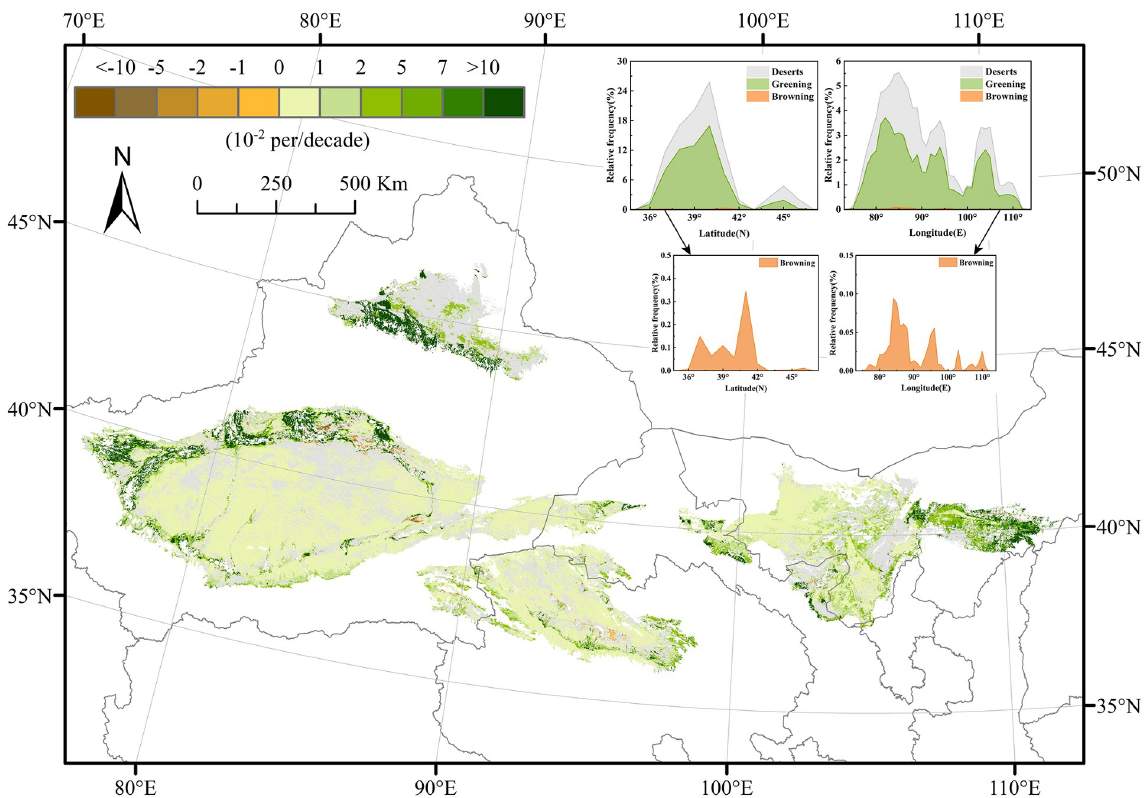
Fig 4. Spatial distribution of greening and browning trends and statistical results based on the longitude and latitude of China’s desert areas from 2000 to 2017. Gray areas represent desert regions with no significant trends at the 5% confidence level. The green and brown areas indicate that the pixel has a significant greening and browning trend, respectively.